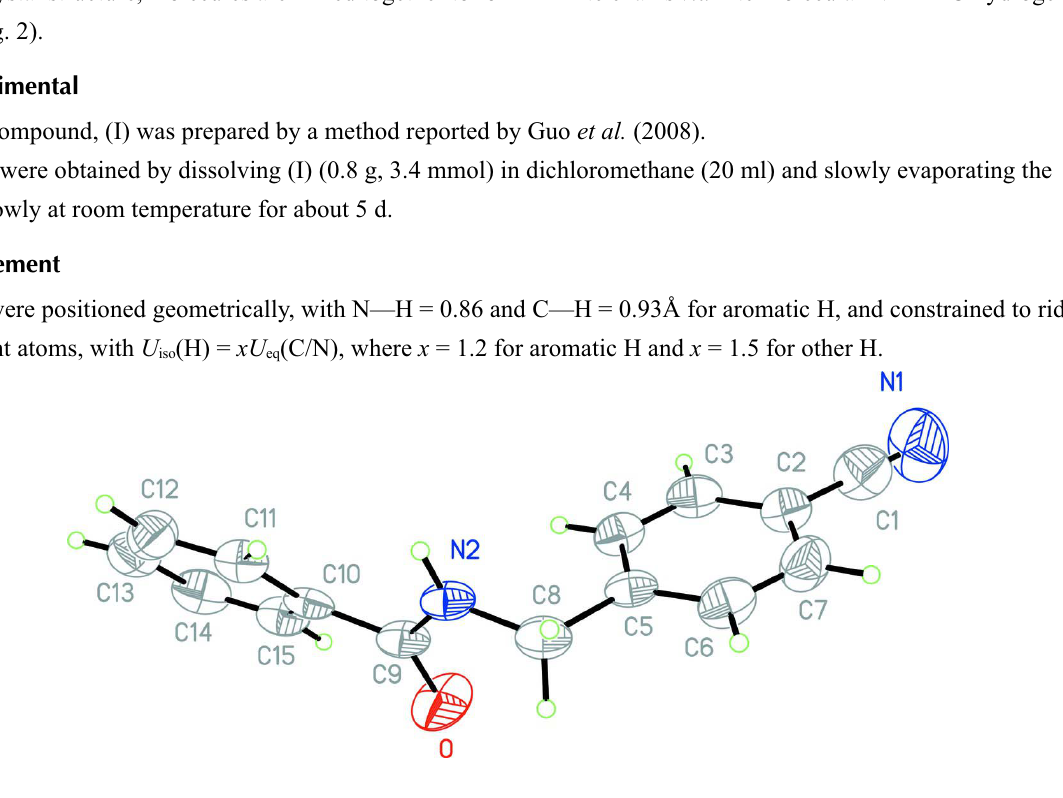
Molecular structure of the title compound showing the atom-numbering scheme. Displacement ellipsoids are drawn at the 50% probability